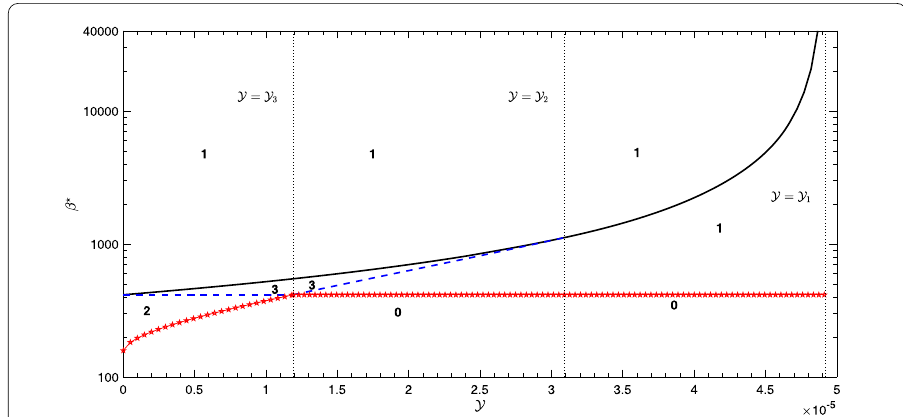
Figure 6 Bifurcation diagram in the plane ( Y , β ) showing the number of endemic equilibria for the different levels of the contact rate β and the maximum treatment capacity Y . The numbers “ 0 , 1 , 2 and 3 ” shown on the subregions denote the number of endemic equilibria in that region. The curve with pentagram represents β = β (cid:3) below which no endemic equilibria exist. Simulations have been done with the parameter values shown in Table